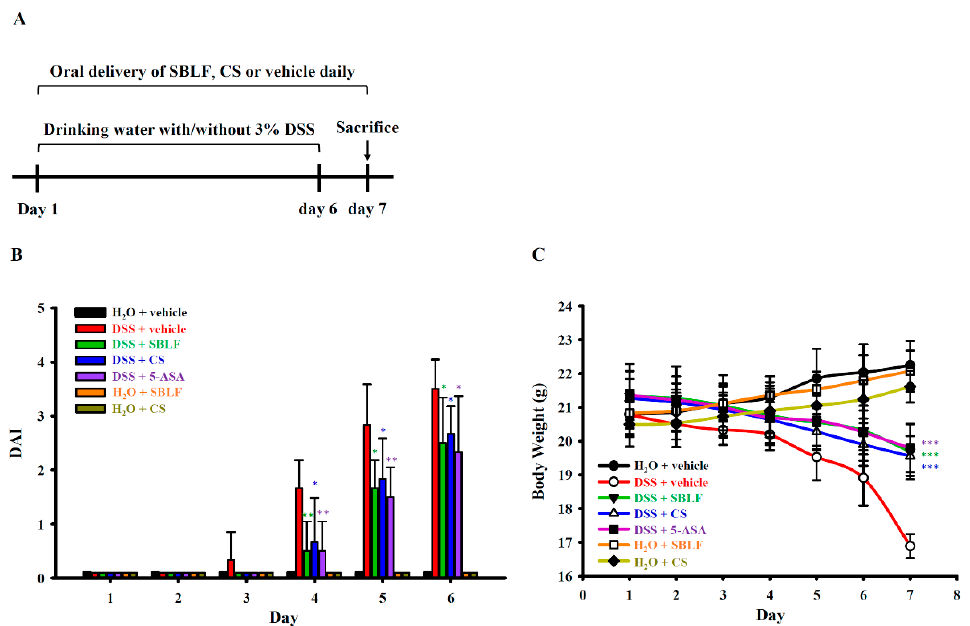
Figure 1. SBLF improves DSS-induced colitis in mice. ( A ) Experimental design of mouse model. ( B ) Effect of SBLF on DAI. ( C ) Effect of SBLF on body weight loss. Bars and lines show the mean ± SD for separate experiments. * p < 0.05, ** p < 0.01 and *** p < 0.001 compared to vehicle + DSS group.